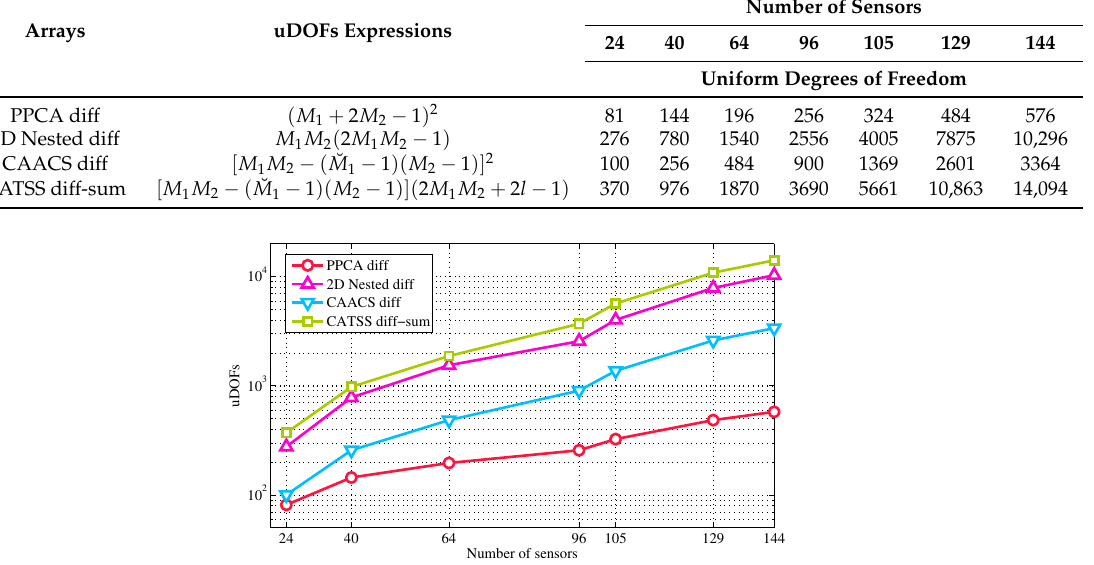
Table 2. Uniform degrees of freedom (uDOFs) comparison of different array configurations.